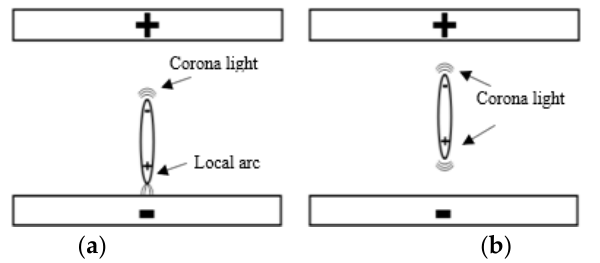
Figure 8. The mechanism of corona on floating particle: ( a ) close to the grounded electrode; ( b ) at the middle of the gap.